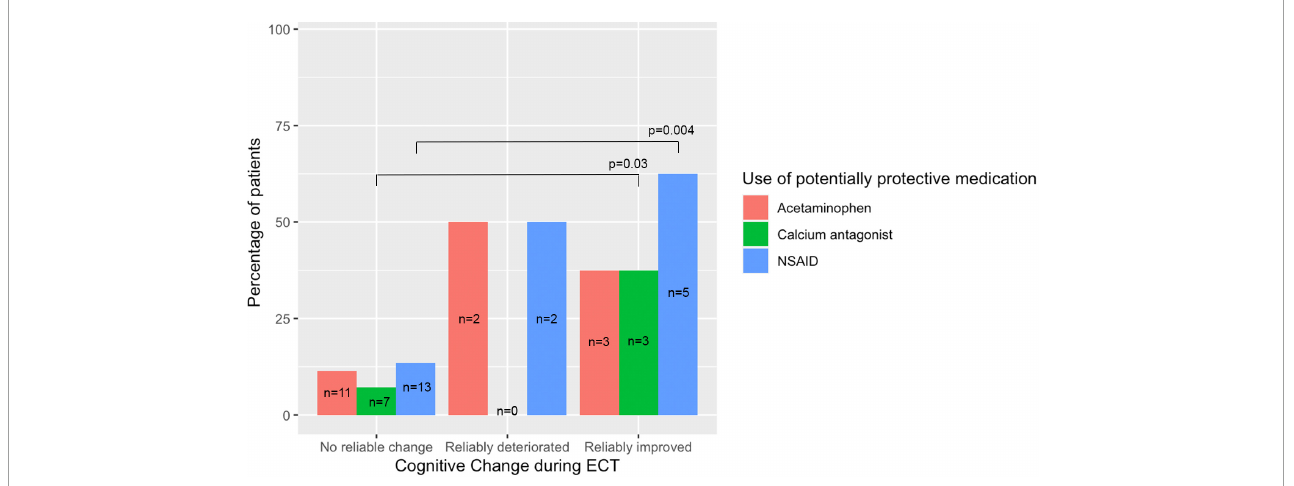
FIGURE3 Frequencies of the use of potentially protective medications in the three cognitive outcome groups. Only the statistically significant comparisons (pairwise Fisher’s exact) are